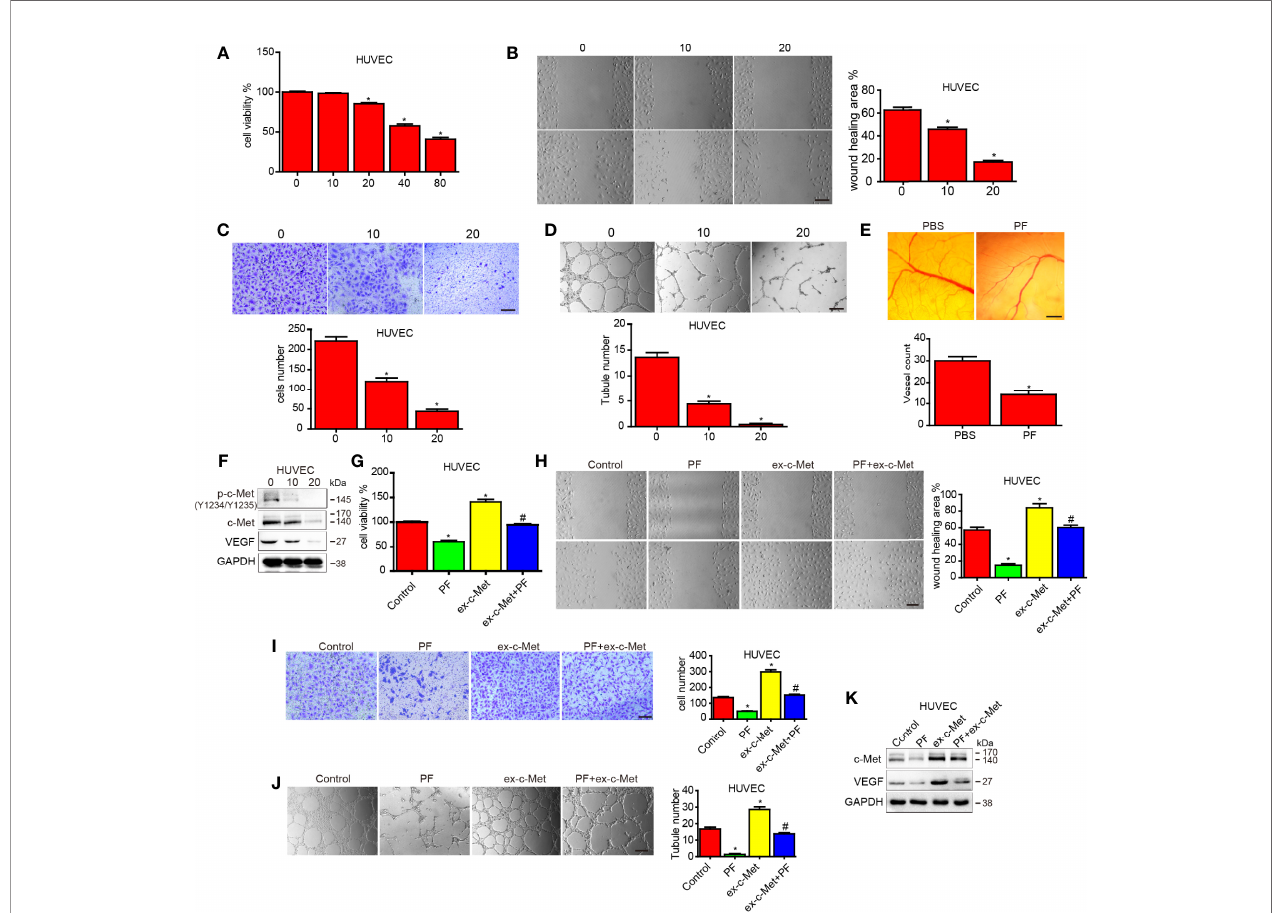
FIGURE 3 | The effect of paeoni fl orin on angiogenesis and c-Met overexpression reduced the effects of paeoni fl orin on angiogenesis in HUVECs. HUVECs were treated with the indicated concentration of paeoni fl orin, and then (A) CCK-8 assay was performed to detect cell proliferation. (B, C) Wound-healing and transwell assays were performed to detect cell migration and invasion ability, respectively. (D) Tube formation assay was performed to evaluate angiogenic ability. (E) CAM assay was used to examine the effect of paeoni fl orin on angiogenesis. CAMs were treated with 0 or 20 m M paeoni fl orin, after which the numbers of micro vessels were counted. (F) The effect of paeoni fl orin on HGF-induced p-c-Met activity in HUVECs. HUVECs were treated with or without 20 m M paeoni fl orin for 24 hours and then incubated with or without 20 nM HGF for 30 minutes. The cells were collected, and western blotting was performed to analyze p-c-Met protein expression. (G) HUVECs transfected with c-Met or vector plasmids for 12 hours were harvested, and 4×103 cells were seeded in a 96-well plate and then incubated with 20 mM paeoni fl orin or PBS for 24 hours. CCK-8 assay was used to detect cell proliferation (H) HUVECs transfected with c-Met or vector plasmids for 12 hours were harvested, and 1×105 cells were seeded in a 6-well plate and then incubated with 20 mM paeoni fl orin or PBS for 24 hours. Wound-healing assay was performed to detect cell migration ability.) (I) HUVECs transfected with c-Met or vector plasmids for 12 hours were harvested, and 2×104 cells were seeded in a transwell chamber. Transwell assay was then performed to evaluate cell invasion ability. (J) HUVECs transfected with c-Met or vector plasmids for 12 hours were harvested, and 1×104 cells were seeded in 24-well plates. Tube formation assay was then performed to evaluate angiogenic ability. (K) HUVECs were transfected with c-Met or vector plasmids for 12 hours and then treated with 20 mM paeoni fl orin for 24 hours. Western blotting was performed to examine c-Met and VEGF protein expression. Control: transfected with vector; paeoni fl orin: transfected with vector+20 mM paeoni fl orin; ex-c-Met: transfected with c-Met; ex-c-Met+paeoni fl orin: transfected with c-Met+20 mM paeoni fl orin. *P<0.05 vs control. # P<0.05, compared with either paeoni fl orin treatment or c-Met transfection